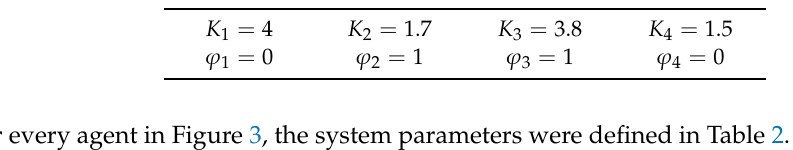
Table 1. Interaction weight of agent.